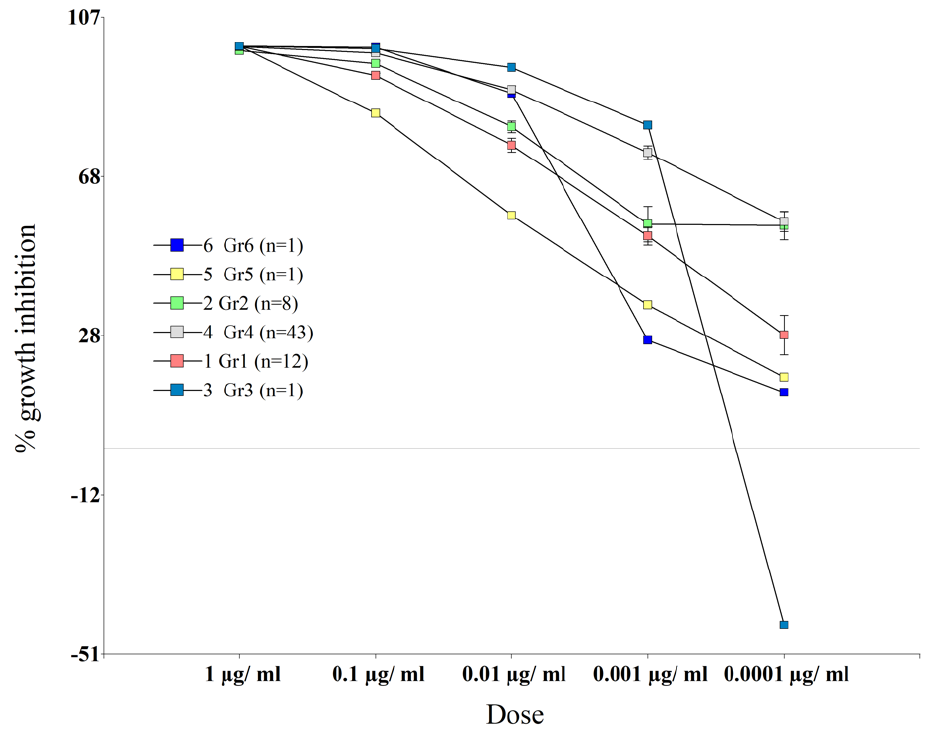
Figure 1. Dynamics of the mycelial growth inhibition of M. roreri groups on PDA plates poisoned with azoxystrobin (darkness/27 °C/6 d). Inhibition values less than zero (horizontal line) indicate growth stimulation compared to the control treatment. Grouping according to cluster analysis of the PGI of 66 isolates (cophenetic correlation 0.809). Bars indicates standard error.